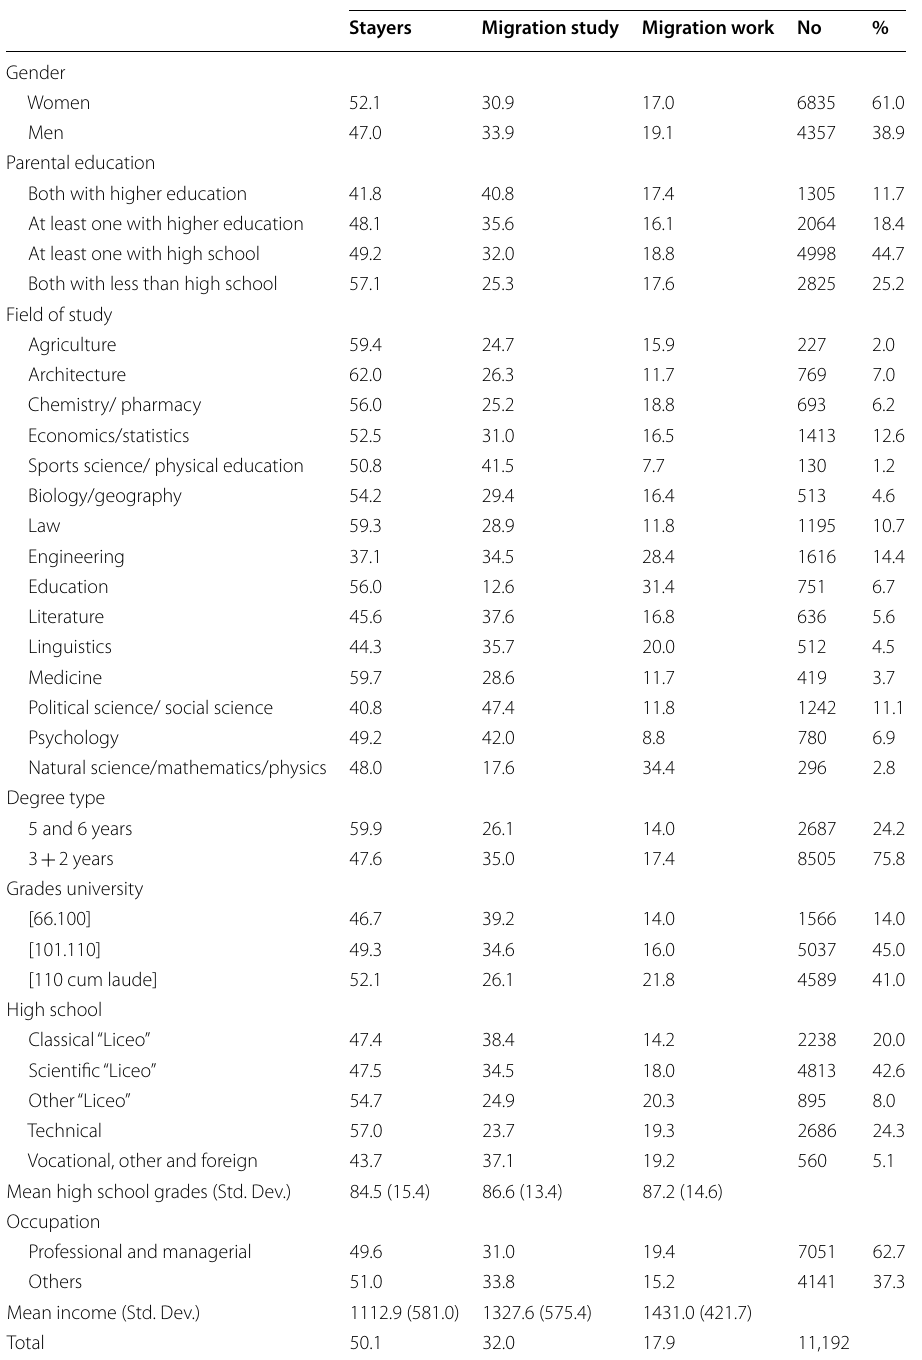
Table 1 Descriptive statistics of Southern Italian graduates by migration behaviour ( N Covariate Row percentages of total